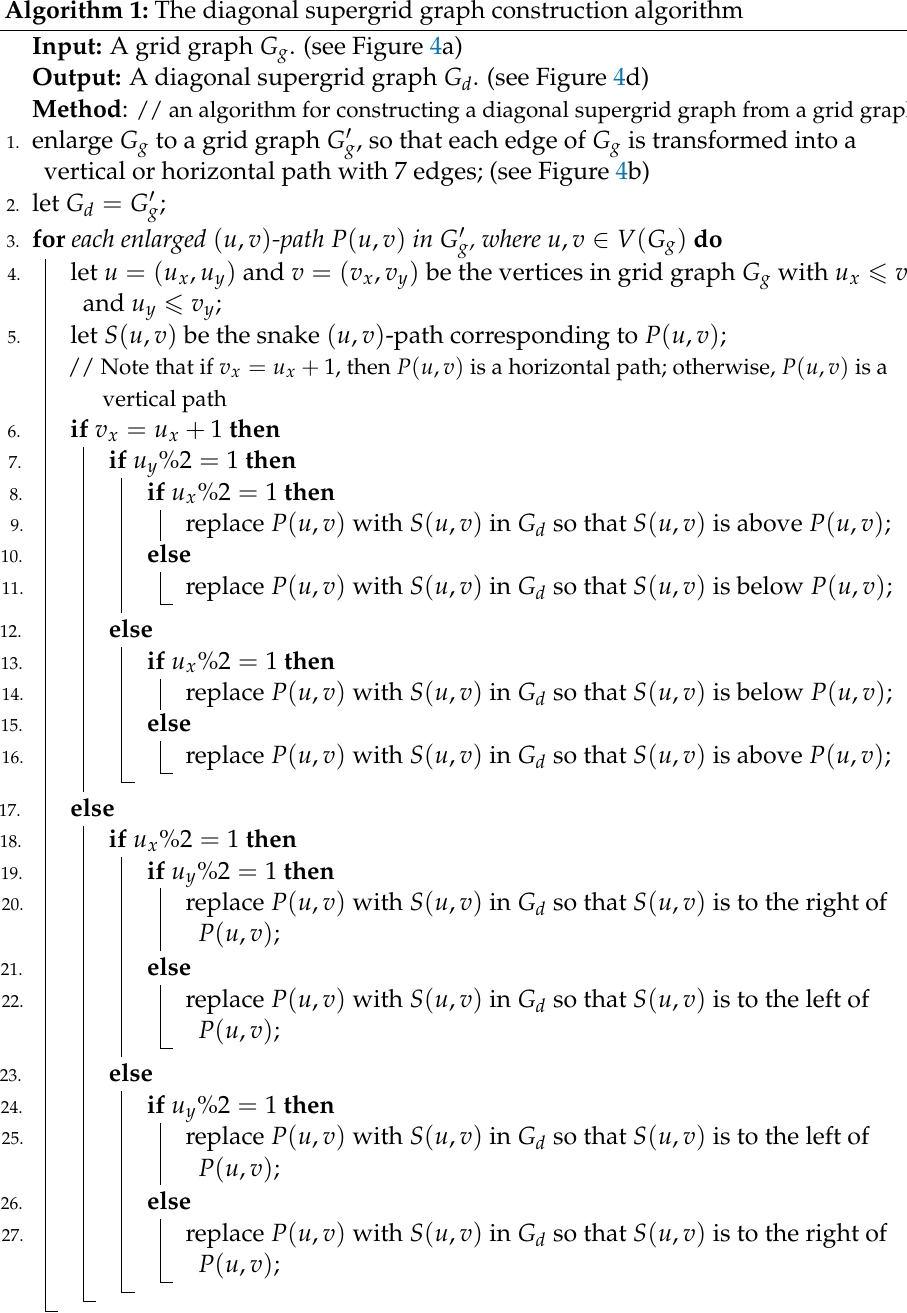
Algorithm 1: The diagonal supergrid graph construction